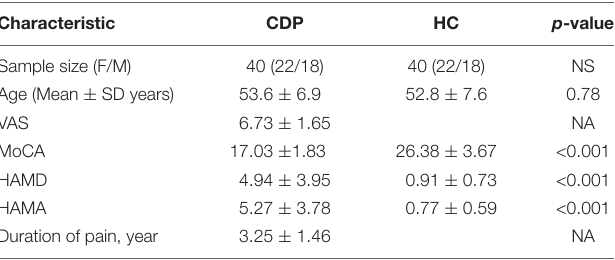
TABLE 1 | Demographics characteristics of cervical discogenic pain (CDP) and healthy controls (HC). Characteristic